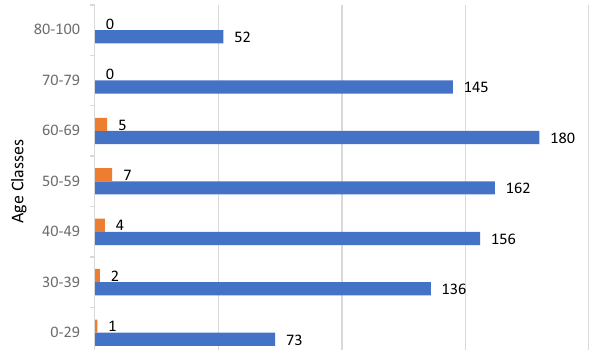
Figure 3. IgG and IgM antibodies and age distribution.